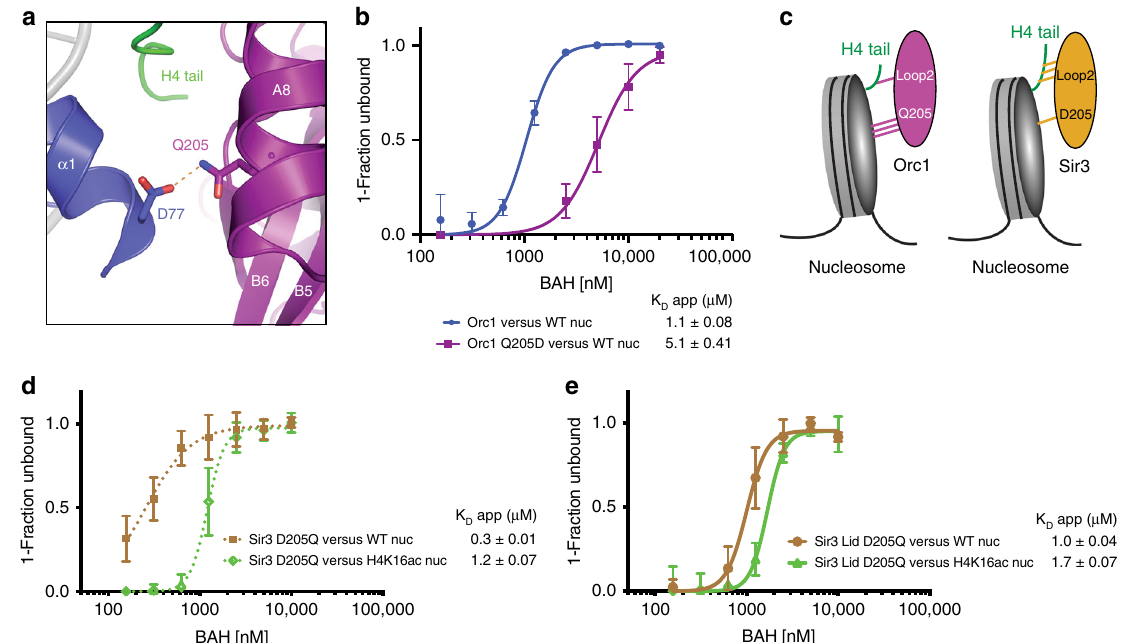
Fig. 4 Q205 in Orc1 compensates for the loss of H4 tail interactions. a Interaction between Orc1 Q205 (purple) and H3 D77 (blue). b Effect of Q205D mutation on Orc1 BAH binding to unmodi fi ed nucleosome (WT nuc) as measured by EMSA. c Model for Orc1 BAH or Sir3 BAH interactions with nucleosome. Interaction strength is represented by dashes. d Binding of Sir3 D205Q to unmodi fi ed and H4K16ac nucleosomes measured by EMSA. e Binding of Sir3 D205Q with Orc1-swapped residues in the Lid of Loop 2 (Sir3 Lid D205Q) to unmodi fi ed and H4K16ac nucleosomes measured by EMSA shows that mutation of these residues reduces the discrimination for H4K16ac. Each data point and error bar represent the mean ± s.d. from three or more independent experiments. The standard errors of dissociation constants ( K D ) are